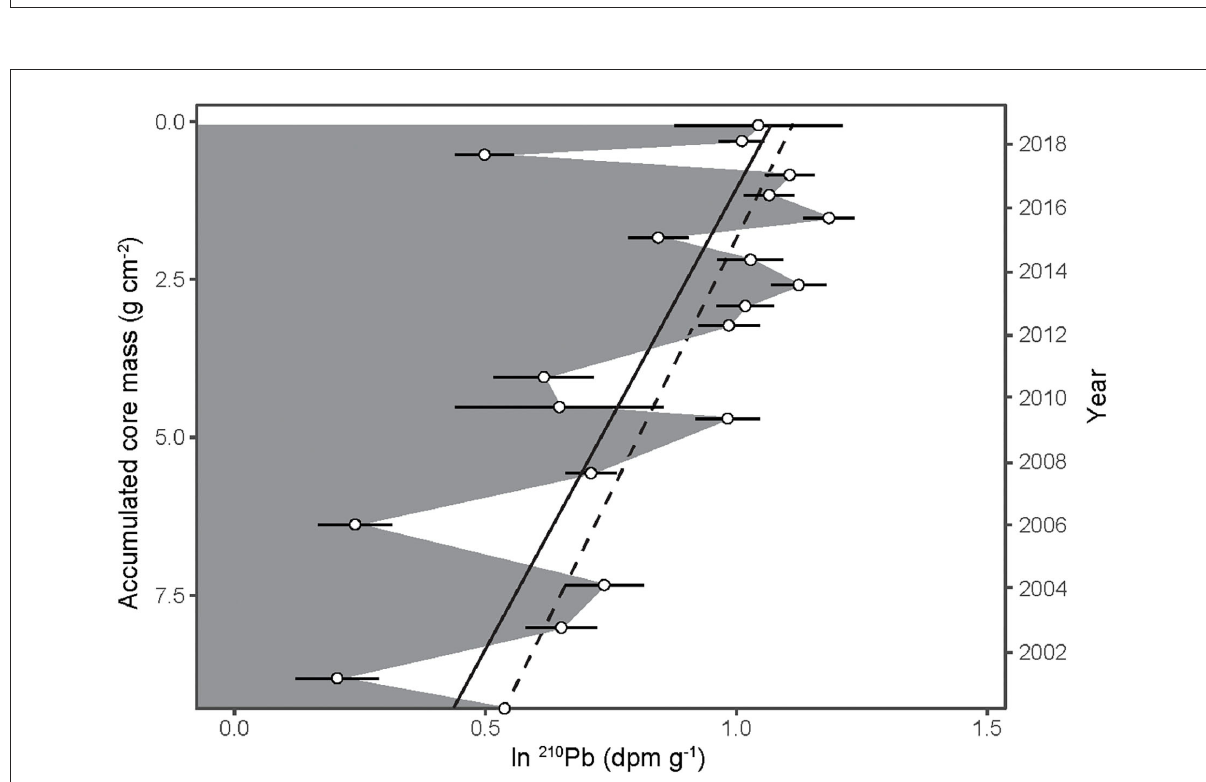
FIGURE3 The natural log of 210 Pb activity (open circles ± 1 SD) as a function of accumulated guano core mass. The slope of the regression is equal to ln(C m /C 0 )/m in Equation (1). The corresponding age of each stratum is shown along the right y-axis. The dashed line depicts the expected 210 Pb decay slope while the solid line illustrates a linear regression of the observed decay of 210